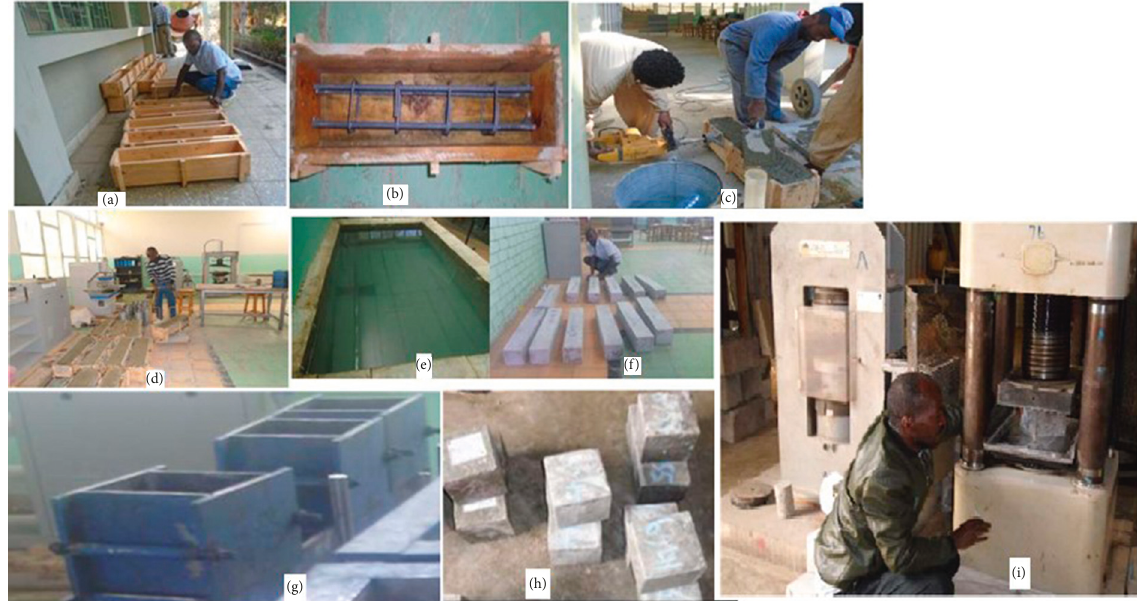
Figure 2: (a) Wooden formwork ready for casting, (b) wooden formwork with the steel cage, (c) mixing of concrete and compaction of beam samples, (d) compacting and placing of concrete in the mold, (e) keeping in water tank, (f) reinforced set of beam, (g) cubical molds, (h) cube sample, (i) compressive strength